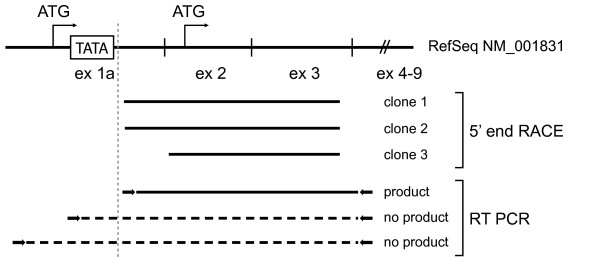
Characterization of the 5'-UTR of the CLU34 transcript by 5'-end RACE and RT-PCR. A colon adenocarcinoma cDNA library was used for 5'-end rapid amplification of cDNA ends (RACE) to determine the sequence of the extreme 5'-end of CLU34 mRNA. None of the three cloned 5'-end RACE fragments or the RT PCR analysis supported the most 5' extreme end of the CLU34 transcript containing the putative TATA-box as suggested by the RefSeq database. The 5'-end RACE results were consistent with results from RT-PCR reactions which only yielded an amplification product if the sense primer was placed downstream of the putative TATA-box.